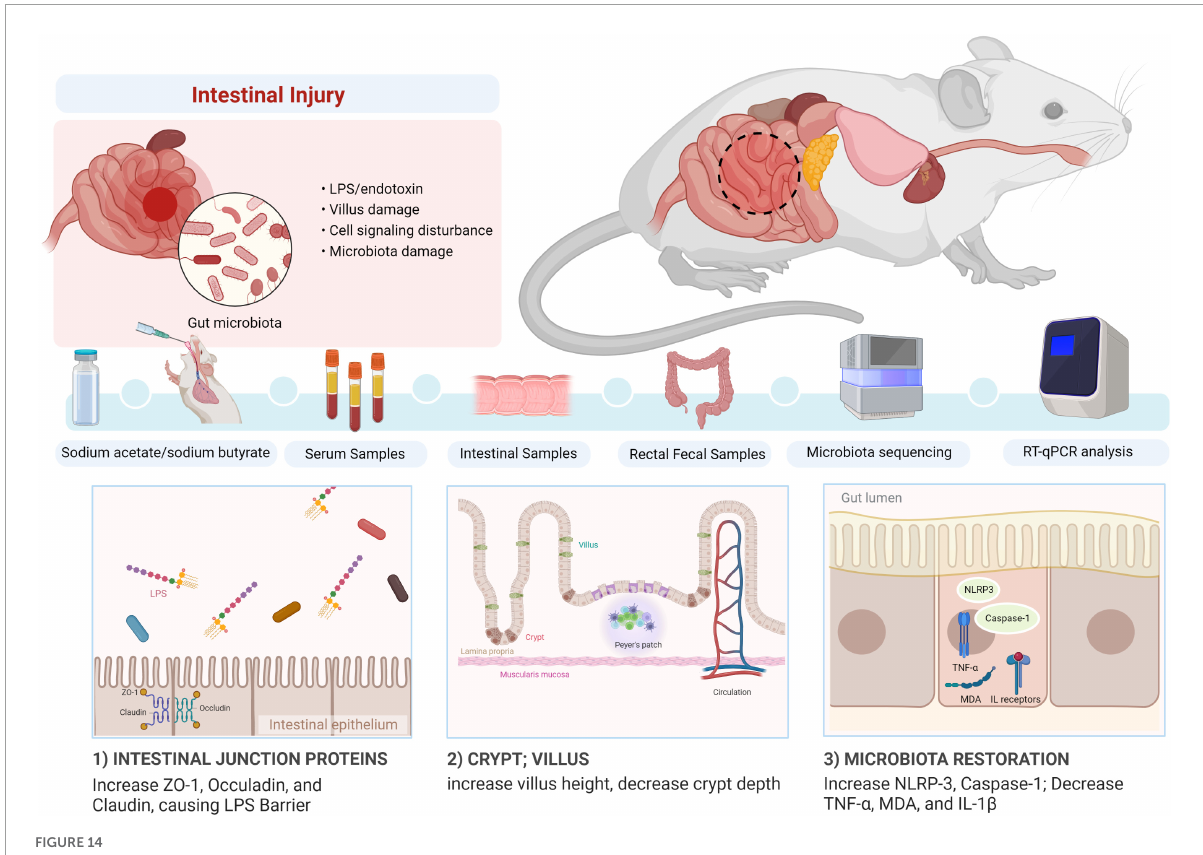
FIGURE14 Summary of the potential mechanism of acetate/sodium butyrate alleviates LPS-induced diarrhea in